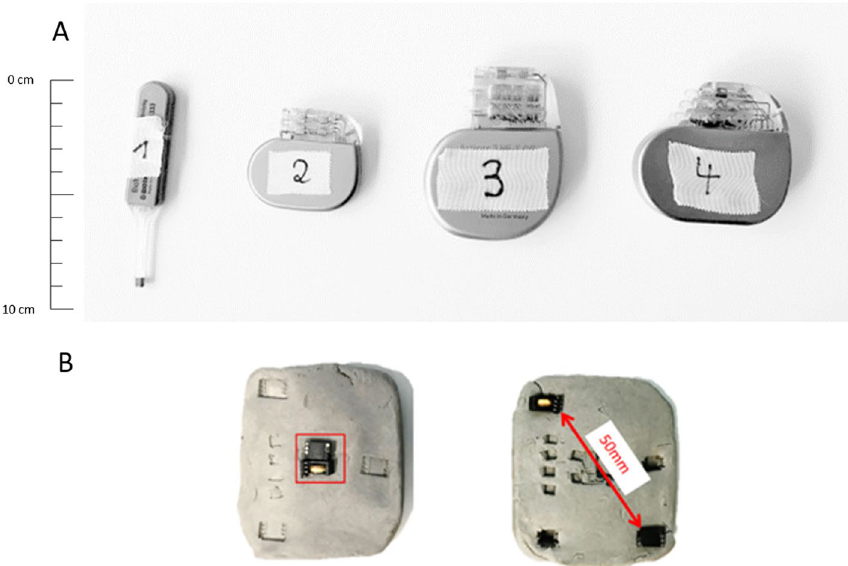
Figure 2. ( A ) Active cardiac devices used for the measurements. All implants are manufactured by BIOTRONIK, Germany. Dev. 1: Cardiac loop recorder (“Biomonitor 2”), Dev.2: Pacemaker (Enticos 4 DR), Dev.3: ICD (Ilesto 7 HF-T), Dev.4: ICD (Activor 7 HF-T QP). The scale bar unit is cm. ( B ) Generic setups: The ferromagnetic material is either all placed in the center (configuration C) or with one half in one corner and the other half in to the opposite corner to be at the maximum distance possible in a state-of-the art ICD (configuration